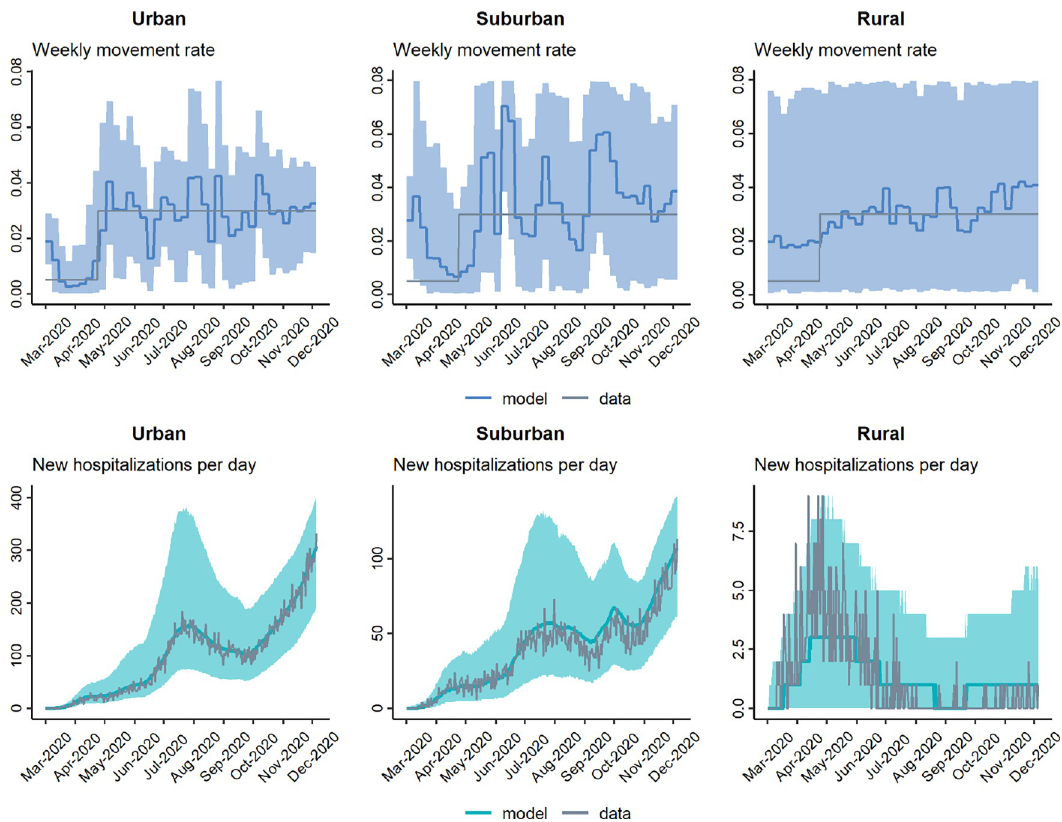
Fig 6. Model-fitting of weekly movement rate m